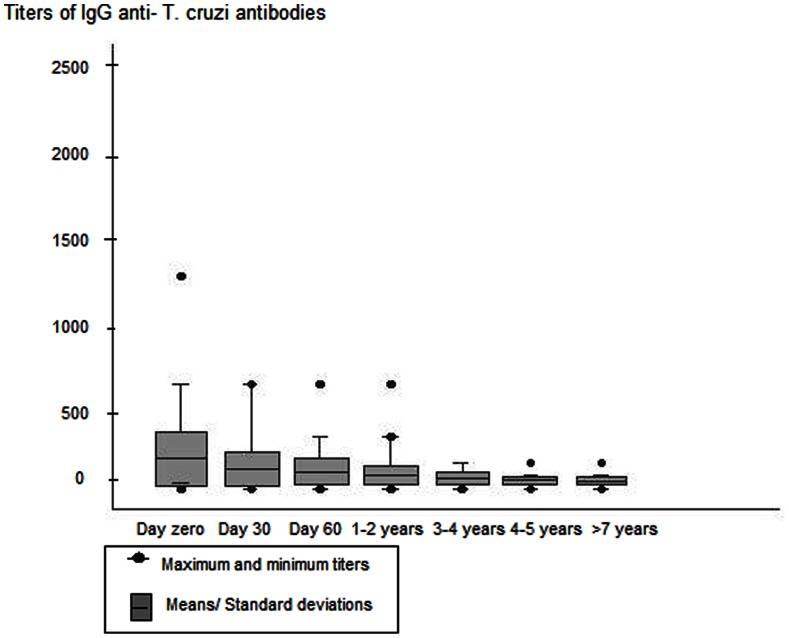
Serological titers of anti-T. cruzi IgG antibody during acute phase and follow-up post treatment.Day zero = first day of treatment; Day30 = 30th day of treatment; Day 60 = 60th day of treatment; 1–2 years = 1 to 2 years post treatment; 3–4 years = 3 to 4 years post treatment; 5–6 years = 5 to 6 years post treatment; >7 years = 7 or more years post treatment. Cochran test comparisons: p<0,005.